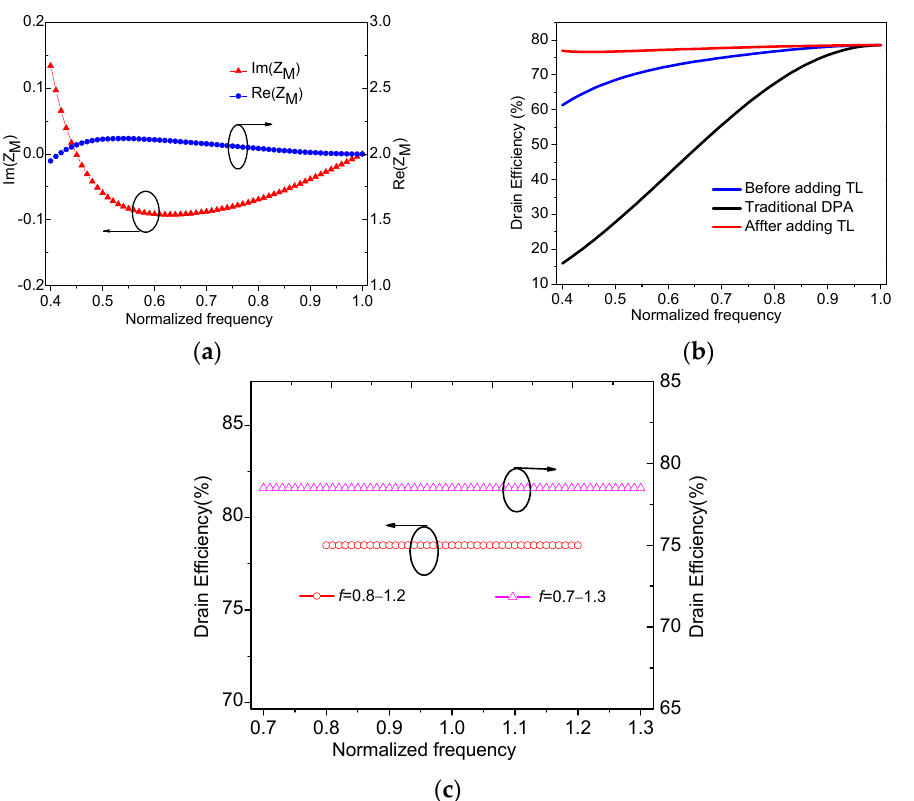
Figure 8. Frequency characteristics: ( a ) impedance Z M,OBO ; ( b ) theoretical drain efficiency in this work; ( c ) theoretical drain efficiency of DPAs in [29,30].